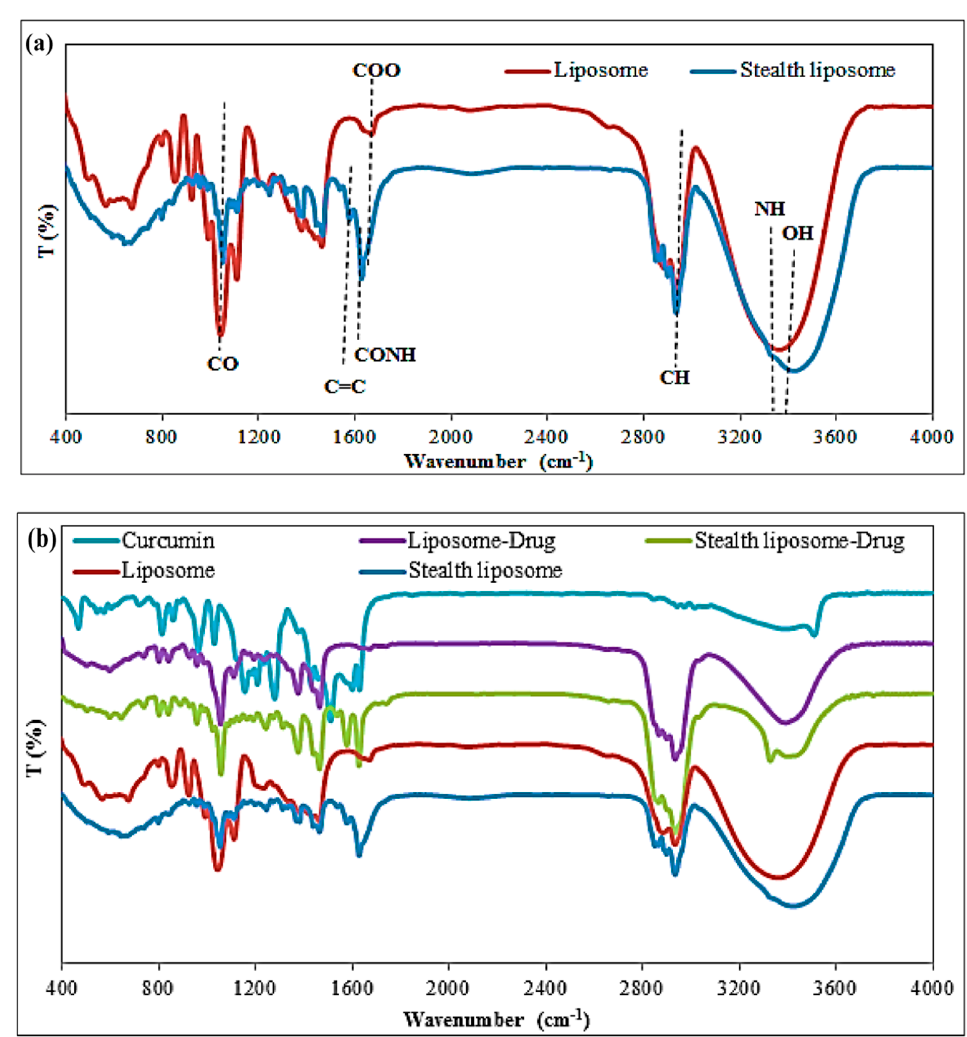
Figure 2. FTIR differences of ( a ) liposome and stealth liposome, and ( b ) liposome, stealth liposome, liposome-drug, stealth liposome-drug, and curcumin.